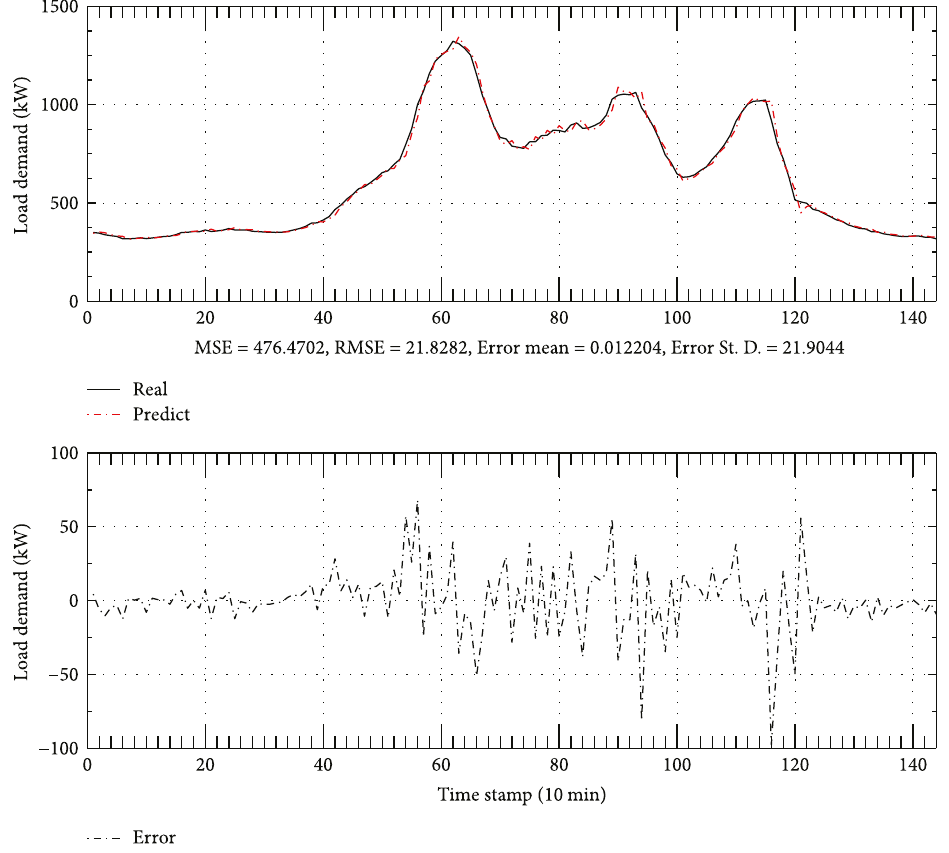
Figure 9: One day ahead RMSE value of demand